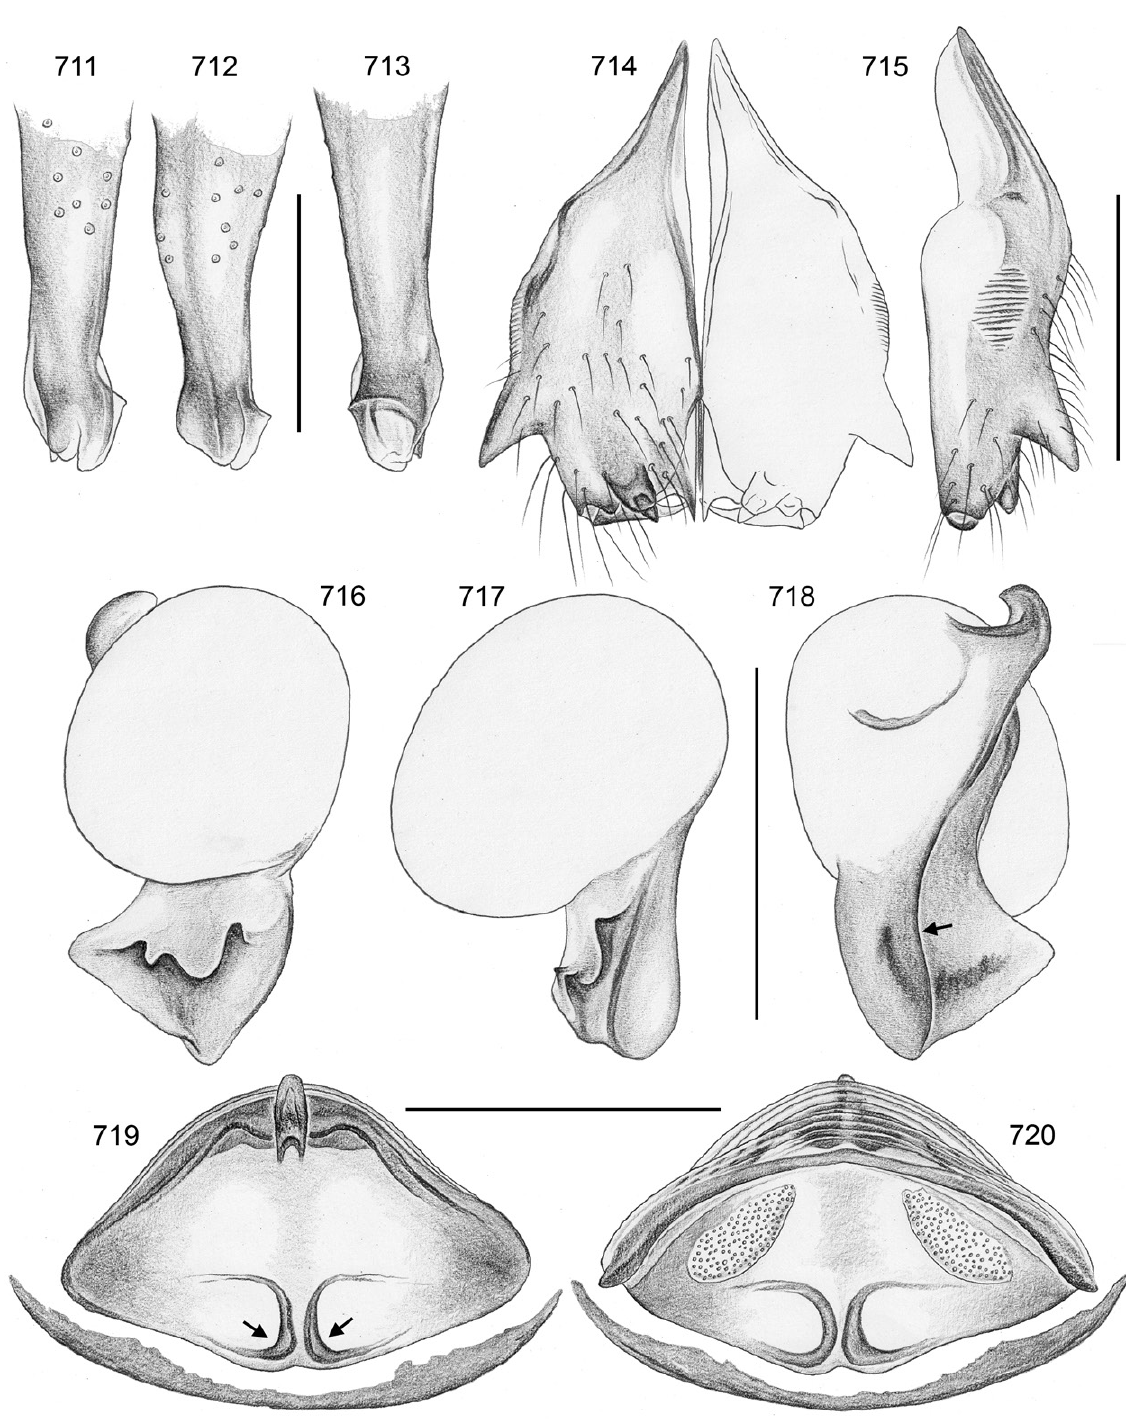
Figs 711–720. Crossopriza miskin sp. nov.; male and female from Oman, wadi near Fasah (ZFMK Ar 22447). 711–713 . Left procursus, prolateral, dorsal, and retrolateral views. 714–715 . Male chelicerae, frontal and lateral views. 716–718 . Left genital bulb, prolateral, dorsal, and retrolateral views; arrow: retrolateral ridge. 719–720 . Cleared female genitalia, ventral and dorsal views; arrows: pockets. Scale bars: 711–713 = 0.2 mm; 714–720 = 0.3